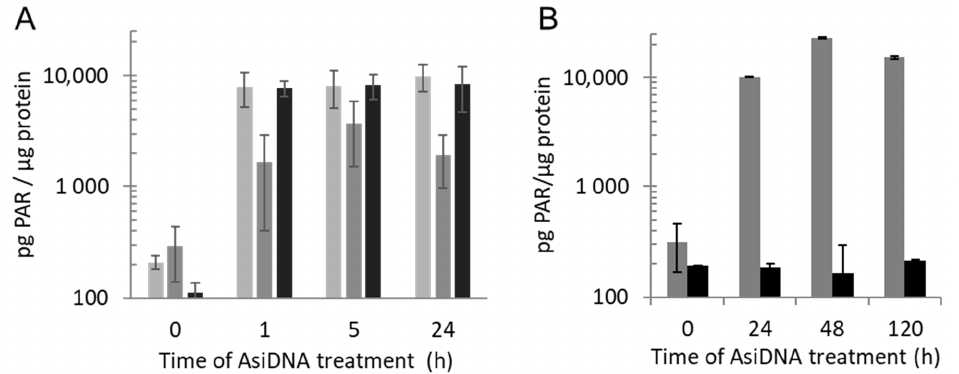
Figure 4. PARP activation by AsiDNA. ( A ) Quantification of PARylation in total (light gray), nuclear (dark gray) or cytoplasmic (black) extracts of SK28 was performed after different times of AsiDNA treatment. ( B ) Kinetics of PARylation in cells treated for different times with AsiDNA and challenge with (black) or without (gray) olaparib during 1 h before PAR quantification.